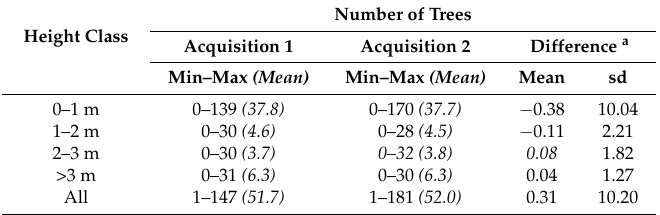
Table 6. Comparison of the number of segmented trees within each 200 m 2 cell derived using two separate ALS acquisitions (569 cells of 200 m 2 ). Mean difference between the two acquisitions and the standard deviation for the difference